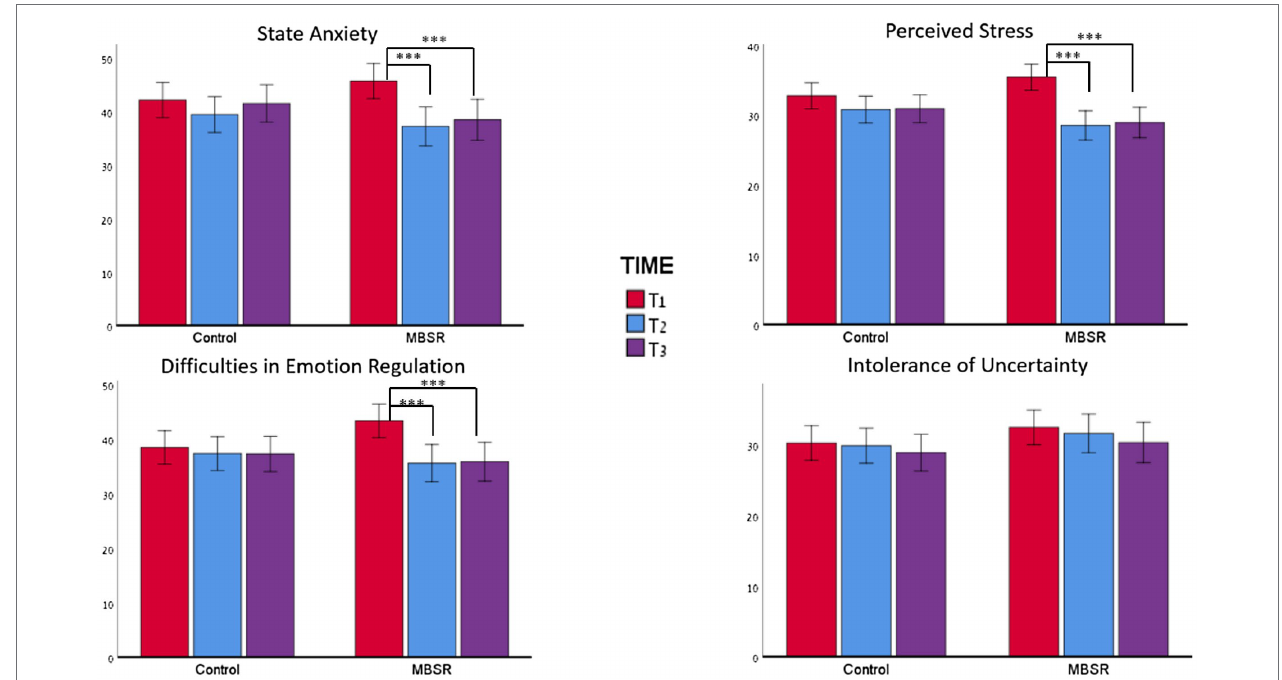
FIGURE 3 | Changes in outcomes across the three time points for state anxiety, emotion regulation, and intolerance of uncertainty. For all measures, no effect of time was observed for the control group. However, in the MBSR group, for all measures except the IUS12, a significant difference was found between T1 and T2 and between T1 and T3. *** p <